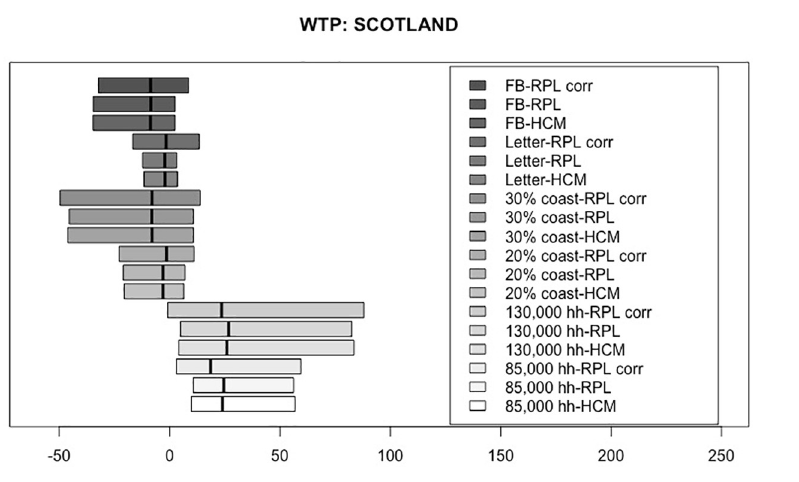
Fig 3. Distribution of WTP measures for